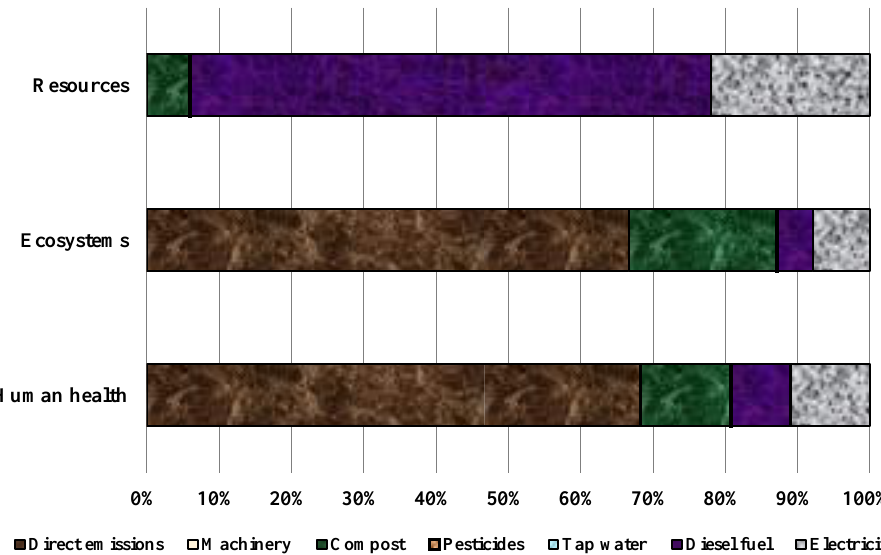
Figure 5. Environmental damages distribution for mushroom greenhouses in Isfahan province.